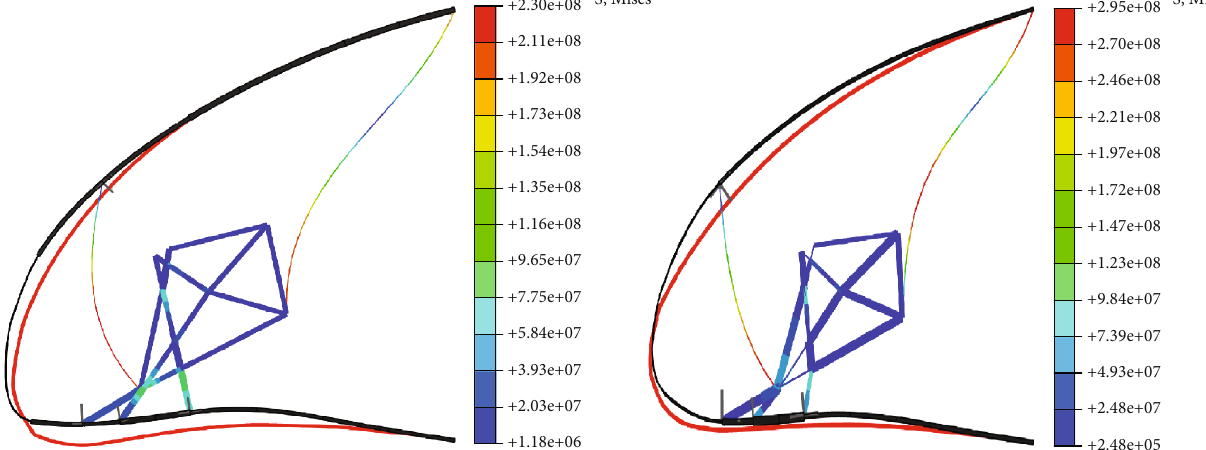
Figure 4: Inner rib (left) and outer rib (right) optimal solutions. Comparison between the optimal deformed shape and the target shape. Stress in the